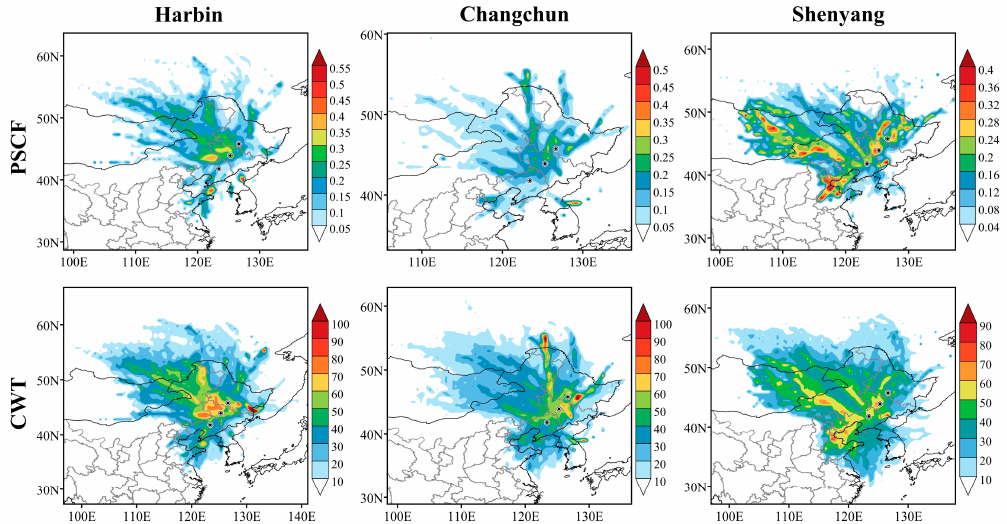
Figure 8. PSCF and CWT analysis results of Harbin, Changchun and Shenyang in 2020. Most of the PSCF (PM 2.5 ) values in Changchun are below 0.3, and the light pollution